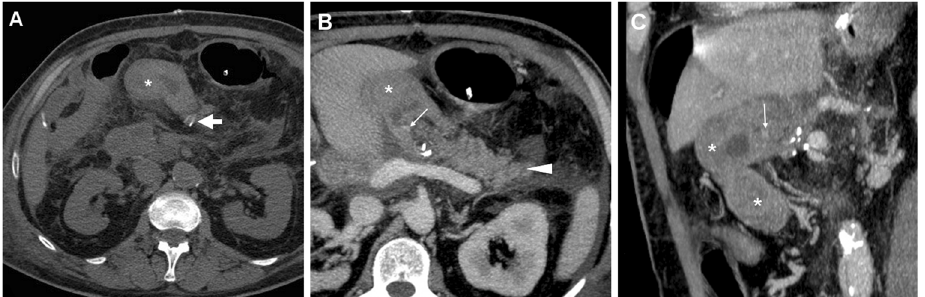
a tiny focus of CM extravasation ( thin arrows ) consistent with active bleeding. Note normal-appearing PR, drainage tube ( thick arrows ). Relaparotomy was required to stop bleeding from a small artery at the site of pancreatic